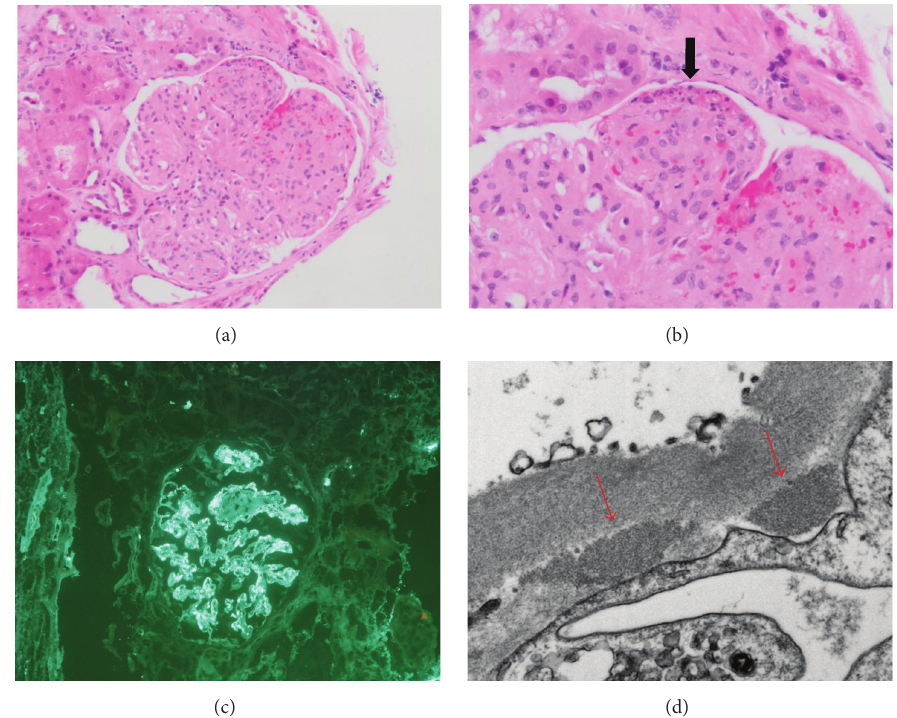
Figure 1: (a) Glomerulus with nodularity, mesangial hypercellularity, and increased mesangial matrix; no crescents were identified (H&E 200x). (b) A segment of the glomerulus showing fibrinoid necrosis and karyorrhexis (arrow) (H&E 400x). (c) Immunofluorescence microscopy showed strong granular IgA staining of mesangial regions and capillary walls (200x). (d) Electron microscopy showed subendothelial electron-dense deposits (arrows)